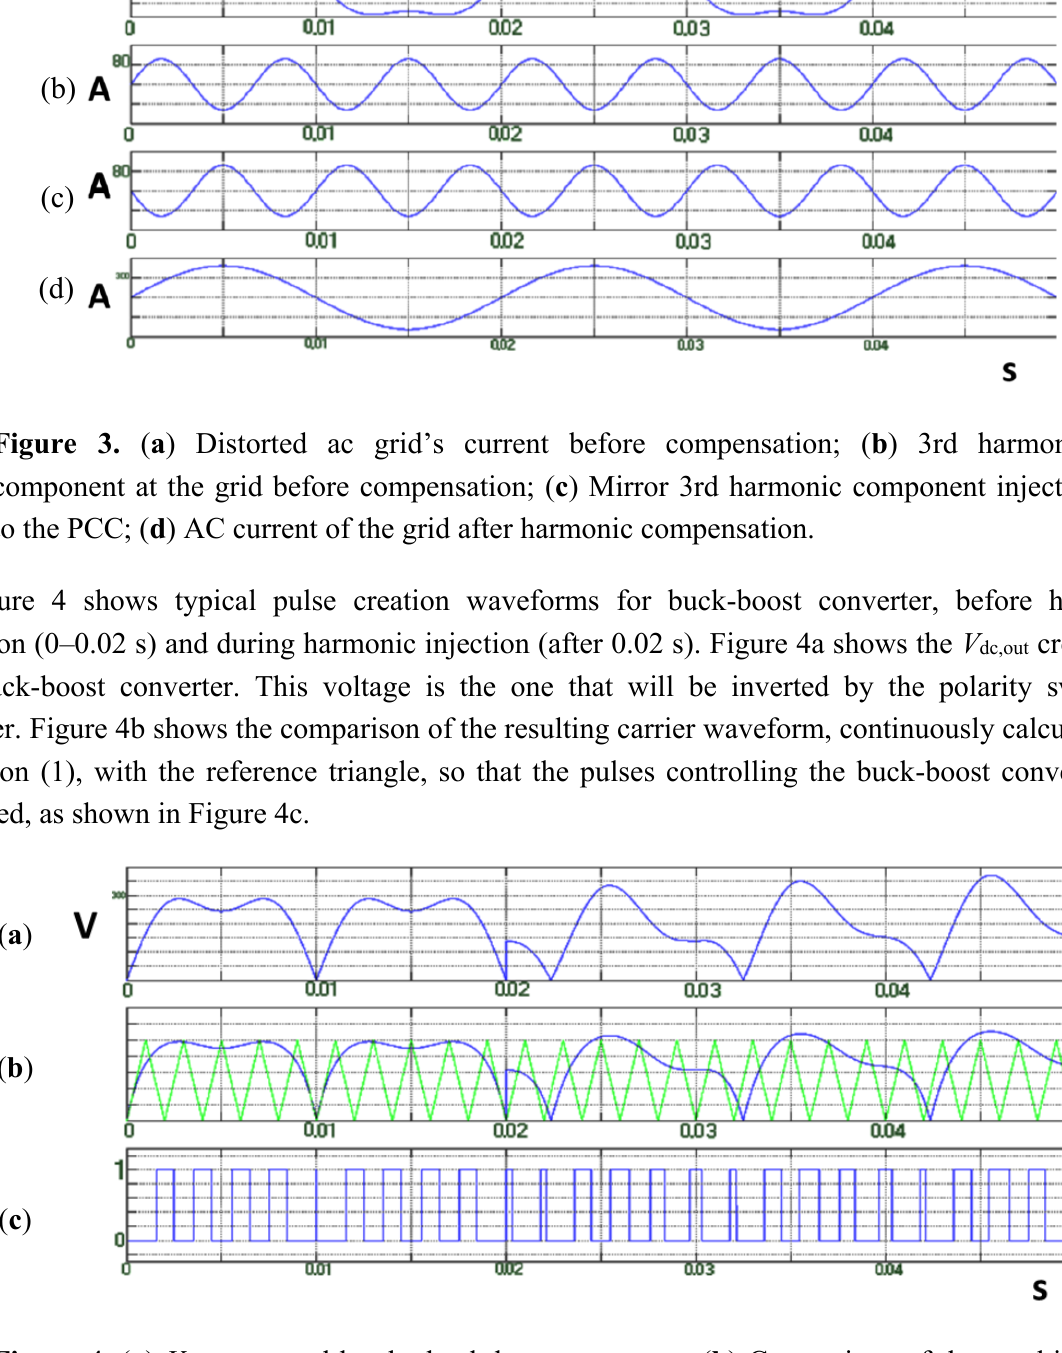
Figure 4. ( a ) V dc,out created by the buck-boost converter; ( b ) Comparison of the resulting carrier waveform with 20 KHz reference triangle; ( c ) Created